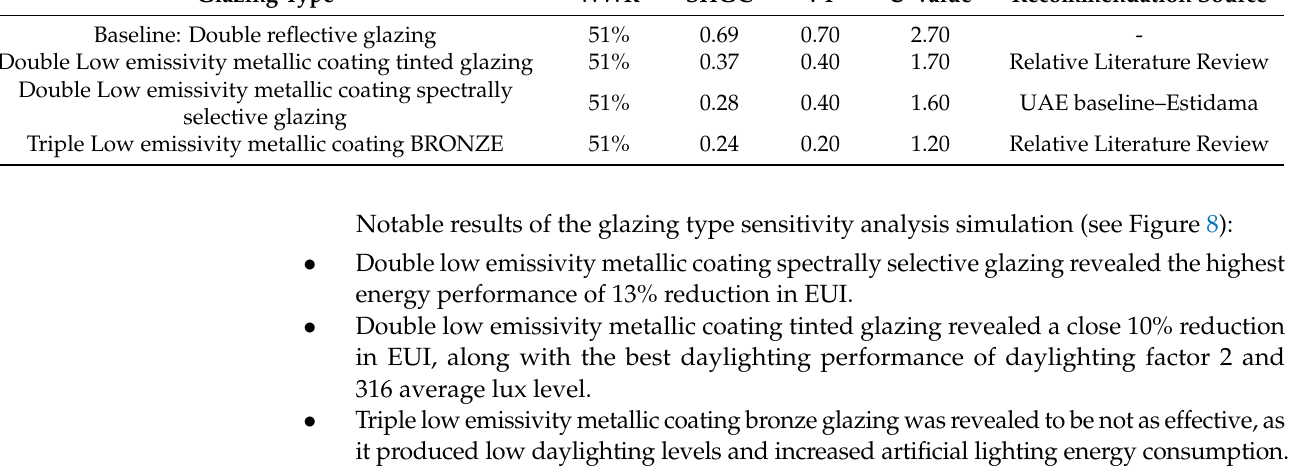
Figure 7. Effect of west façade WWR on the average illuminance (lux) in a typical office.